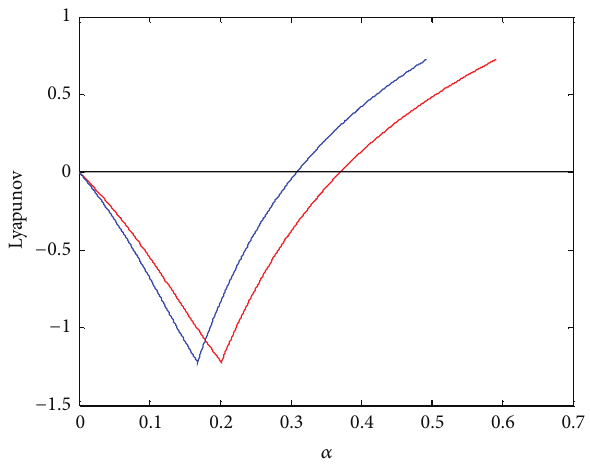
Figure 8: The related maximal Lyapunov exponents as a function of the controlling factor 𝑘 with the parameter 𝛼 = 0.46